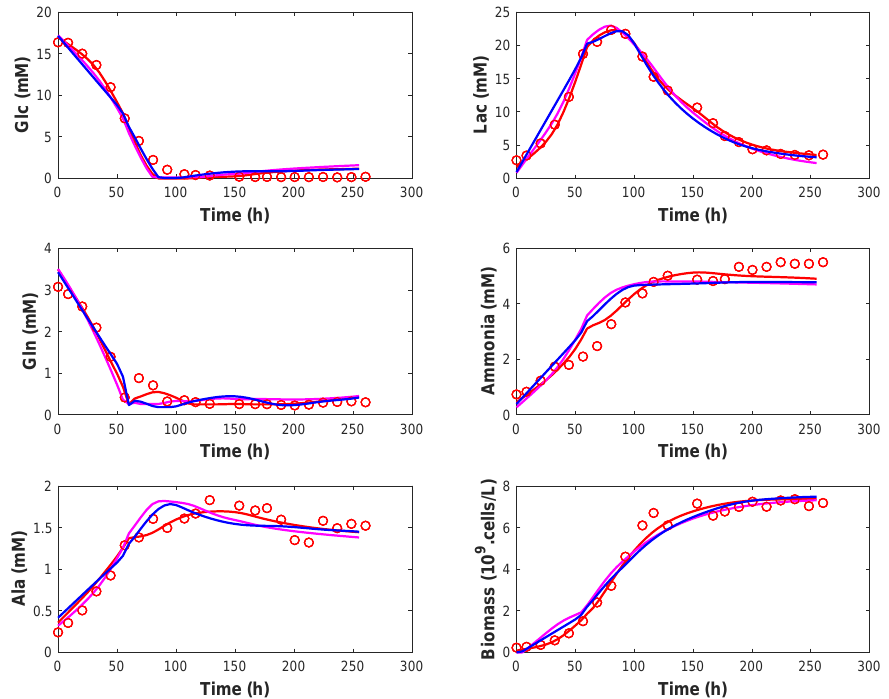
Figure 10. Prediction of the time evolution of the extracellular measured species in dataset # 2— numerical results from the optimization problem (black curves) using MLP with ten neurons (red curves), five neurons (magenta curves) and three neurons (blue curves) in the hidden